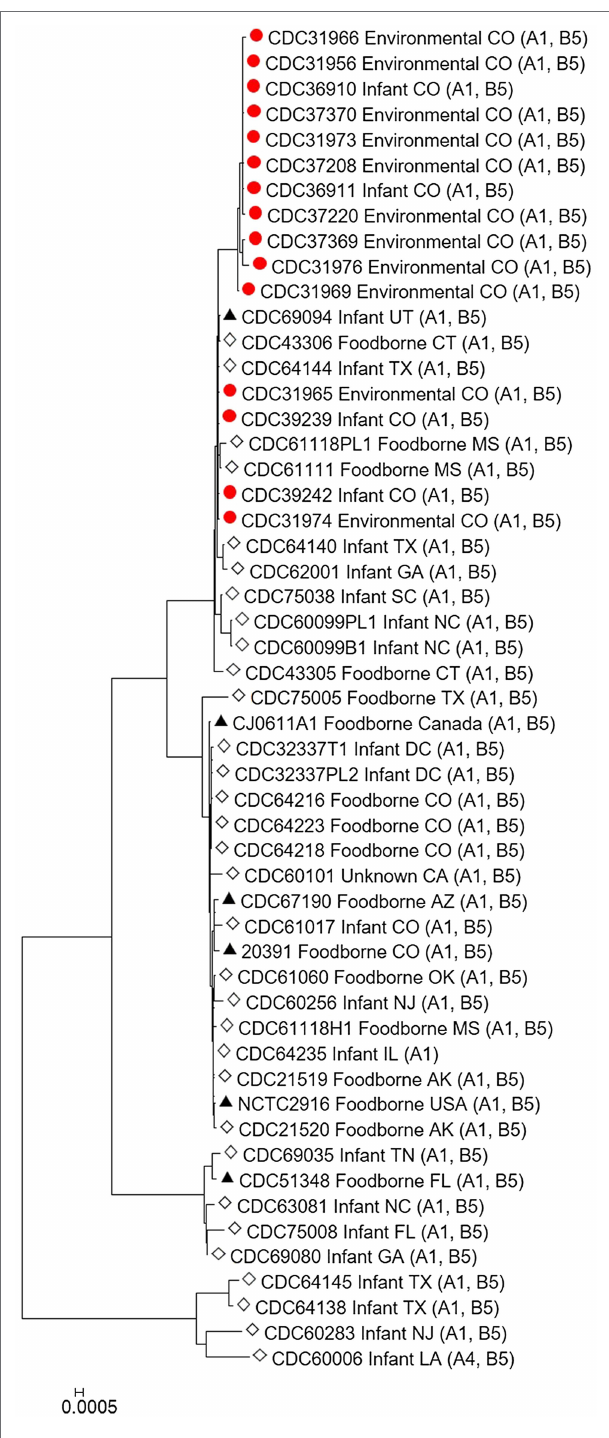
FIGURE 1 | Neighbor-joining tree of Clostridium botulinum type A(B) isolates. Tree was drawn using Mashtree and includes study strains harboring both bont /A1 and bont /B5 genes as described in Table 1 (red circles), reference sequences from NCBI (black triangles), and other unpublished sequences from the CDC reference collection (white diamonds), as described in Supplementary Table 1. Scale bar represents the Mash